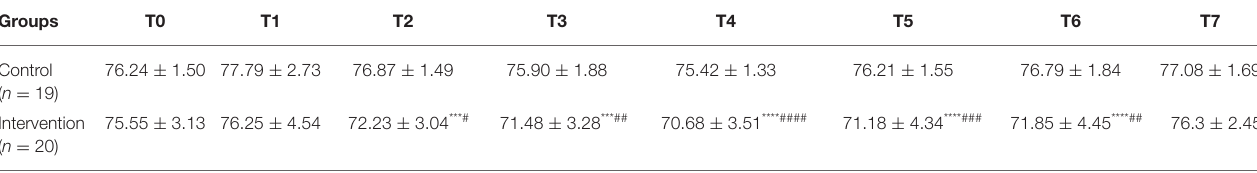
TABLE 4 | Comparison of rSO 2 (%) at each time point between control and intervention groups. Groups